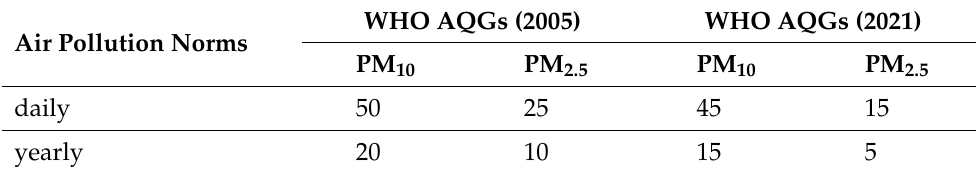
Table 2. Air quality: WHO guidelines 2005 and